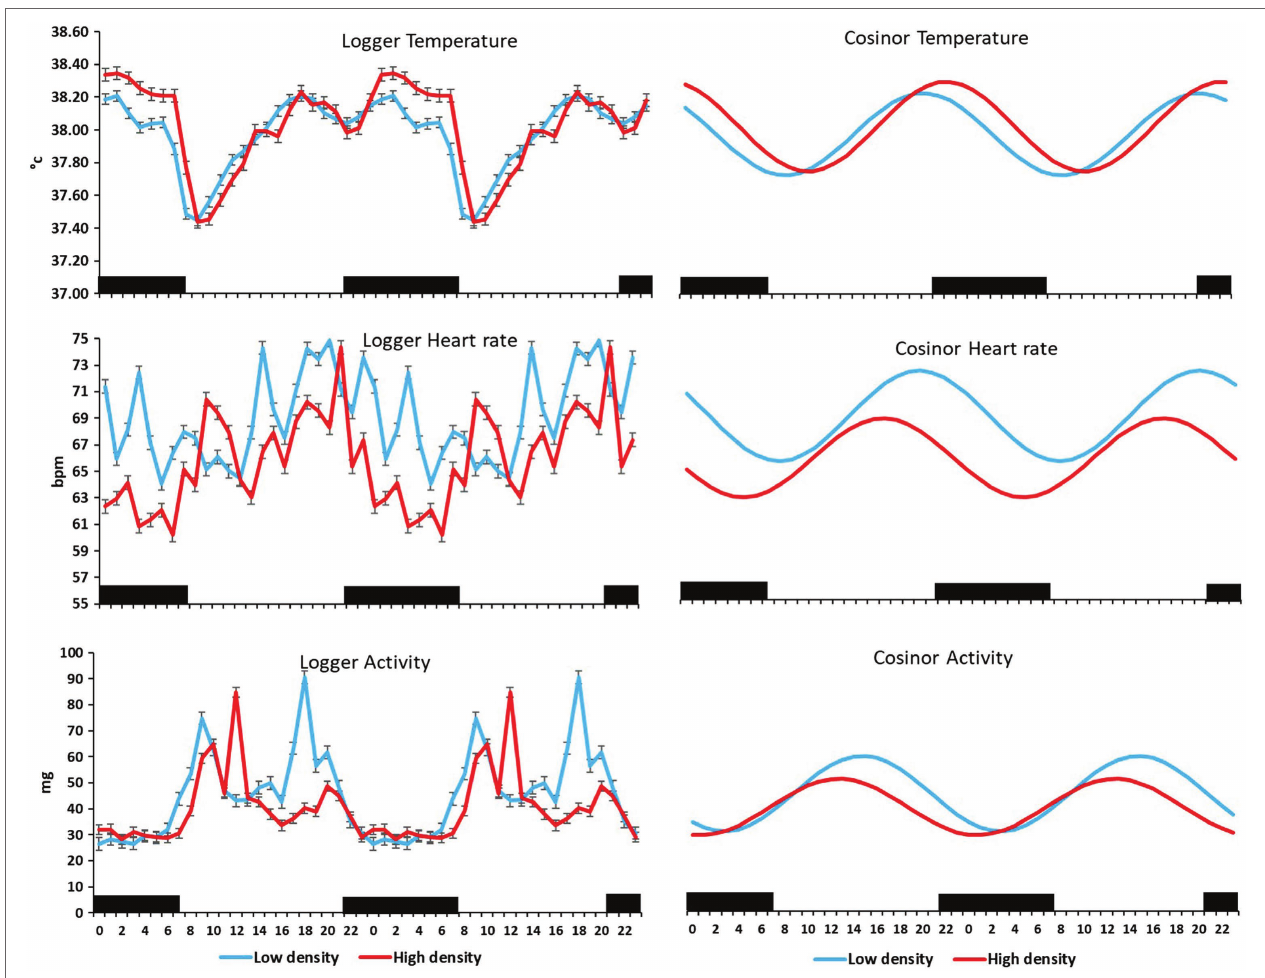
FIGURE 5 | Mean (±SEM) temperature ( ° C), heart rate (bpm), and activity (standard acceleration of gravity, g ) measured by subcutaneous bio-loggers (left panel) , and the cosine curve of a 24-h activity rhythm (right panel) of six cows on 5 days grazing at 1.5 LSUs/ha (low density), followed by 5 days of grazing at a density of 128 LSUs/ha (high density). Black areas indicate night (22:00–06:00 h).